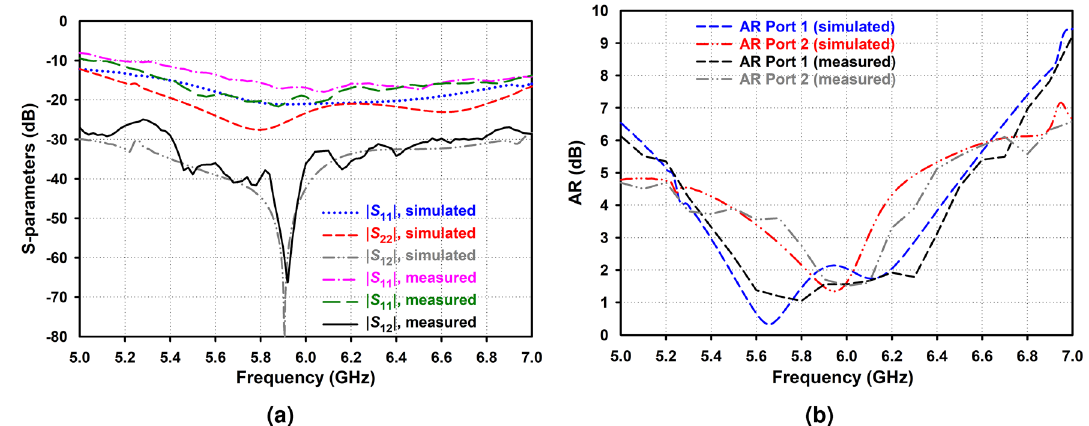
Figure 11. Simulated and measured ( a ) S-parameters and ( b ) ARs of the proposed